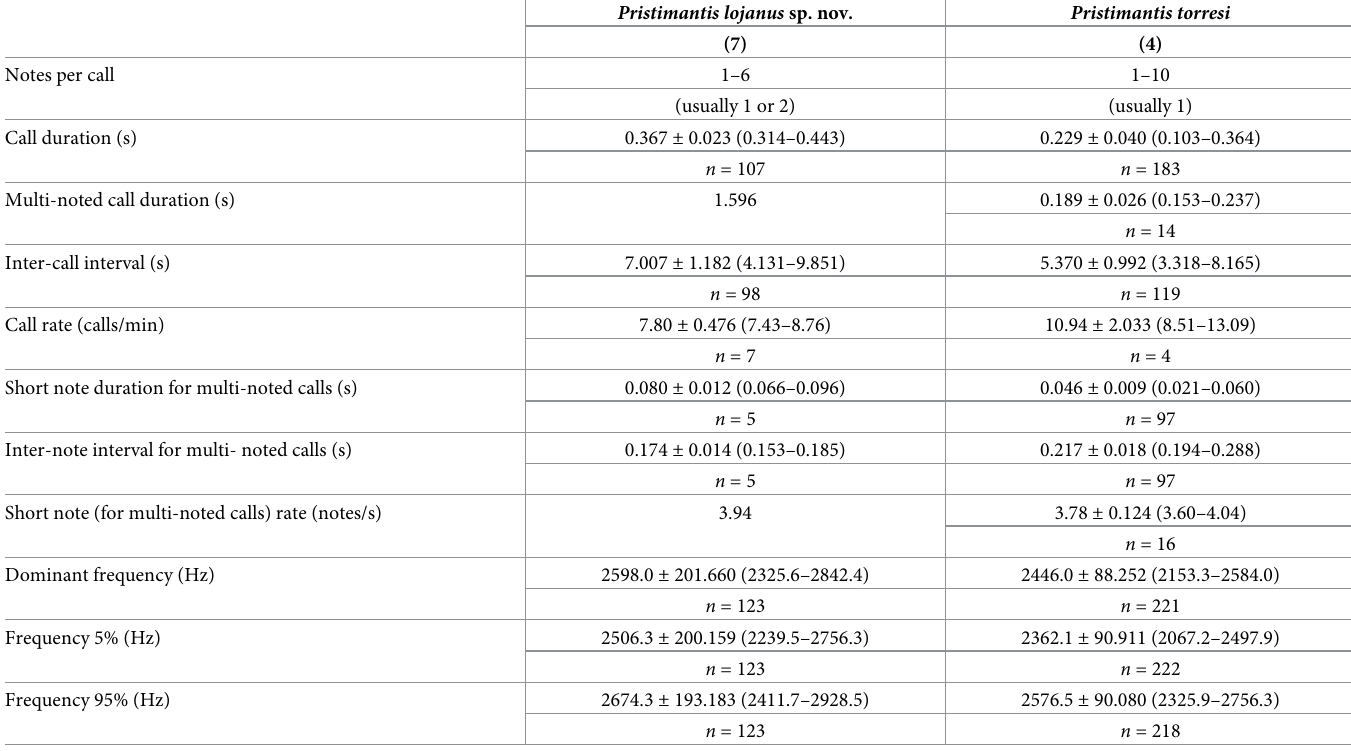
Table 2. Quantitative description of the advertisement calls (mean ± SD, range and n ) of Pristimantis lojanus sp. nov. and P . torresi . Pristimantis lojanus sp.